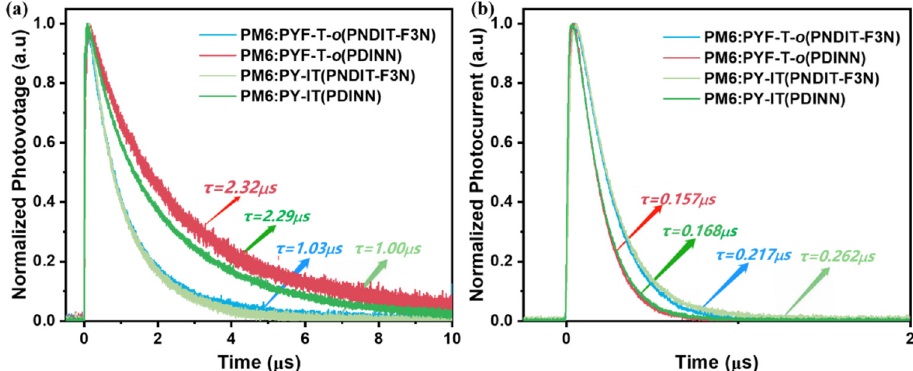
Figure 6. TPV ( a ) and TPC ( b ) decays of the PM6:PYF-T- o and PM6:PY-IT-based devices.